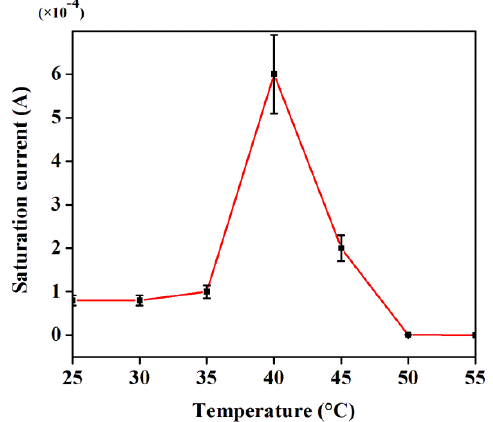
Figure 5. Temperature dependent saturation current in the absence of external magnetic